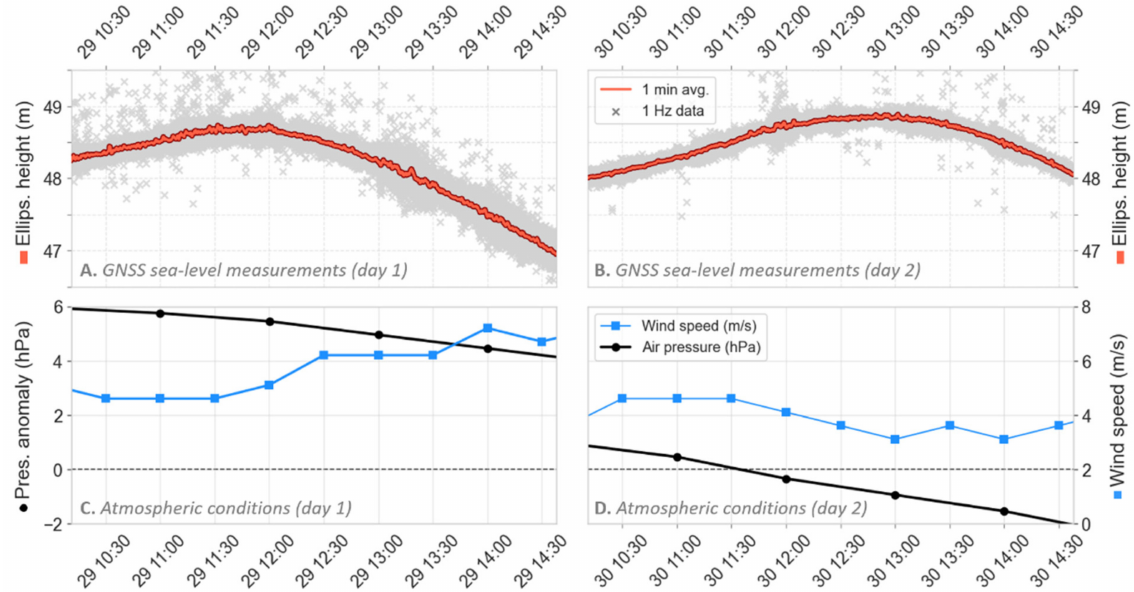
Figure 4. Cyclop é e SSH measurements during the first ( A ) and second ( B ) day of the survey, for raw (1 s) (light grey crosses) and filtered (1 min) (red lines) measurements. These measurements are located at the same geographic position with a time interval of 24 h. Air pressure anomalies (black lines, left axis) and wind speed (blue lines, right axis) are displayed for the first ( C ) and second ( D ) day of the campaign (M é t é o-France data at Chassiron station on Ol é ron